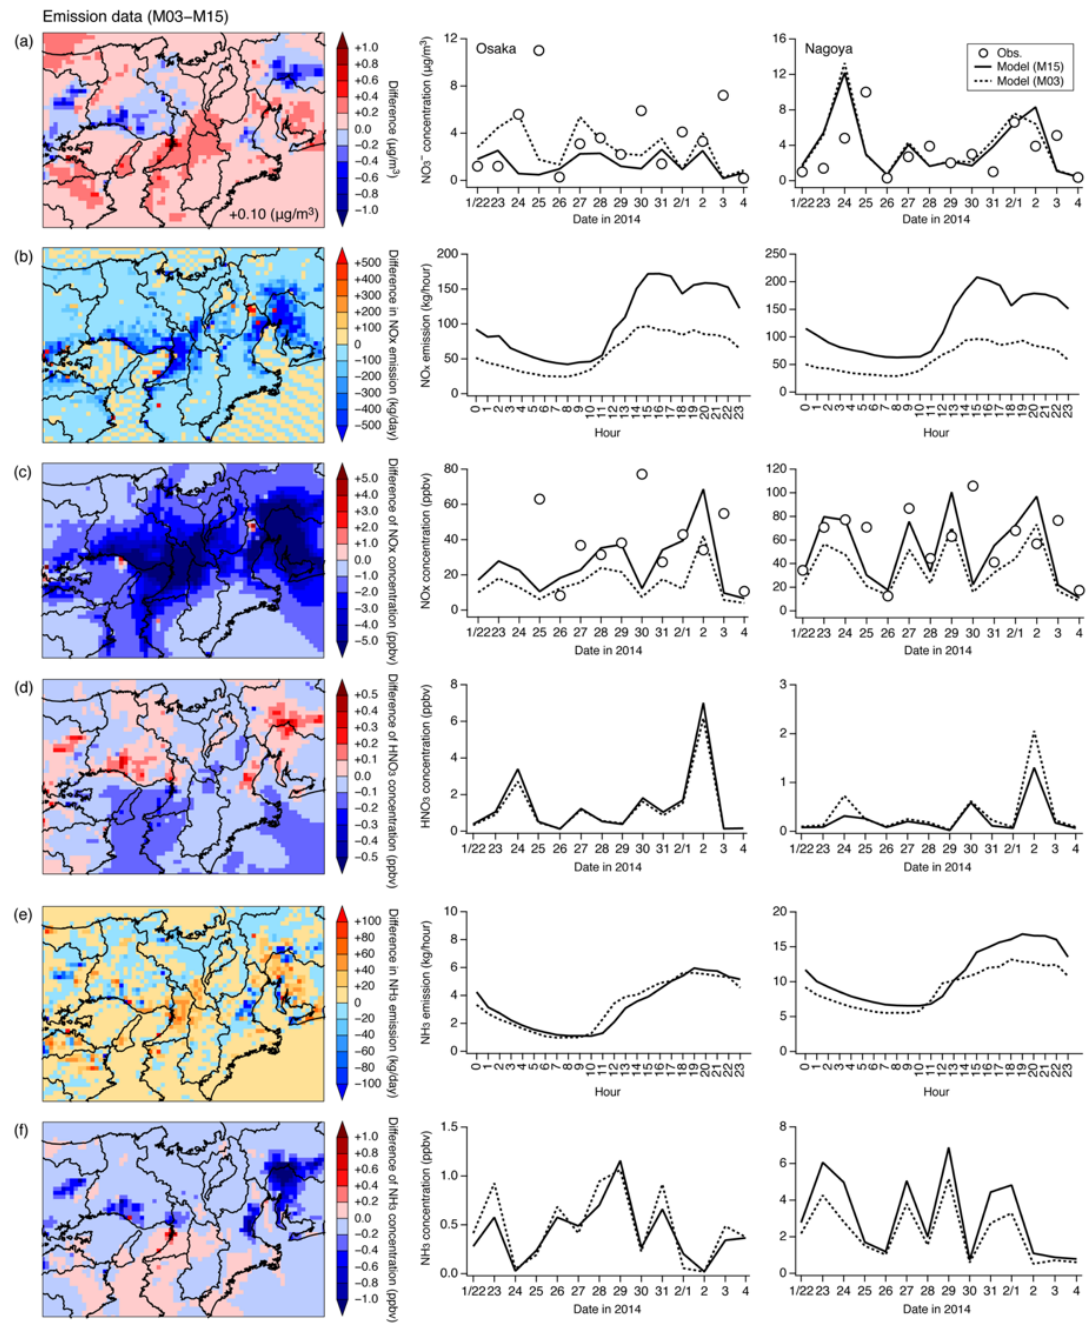
Figure 9. (Left) Spatial distributions of the difference caused by emissions between M03 and M15 over domain 3. (Right) Temporal variation of models M03 and M15 at specific sites in Osaka and Nagoya (see Figures 2 and 5). The analysis targets were ( a ) NO 3 − concentration, ( b ) NO x emissions, ( c ) NO x concentration, ( d ) HNO 3 concentration, ( e ) NH 3 emission, and ( f ) NH 3 concentration. The value shown in the lower-right side of the panel in ( a ) indicates the spatially averaged difference.